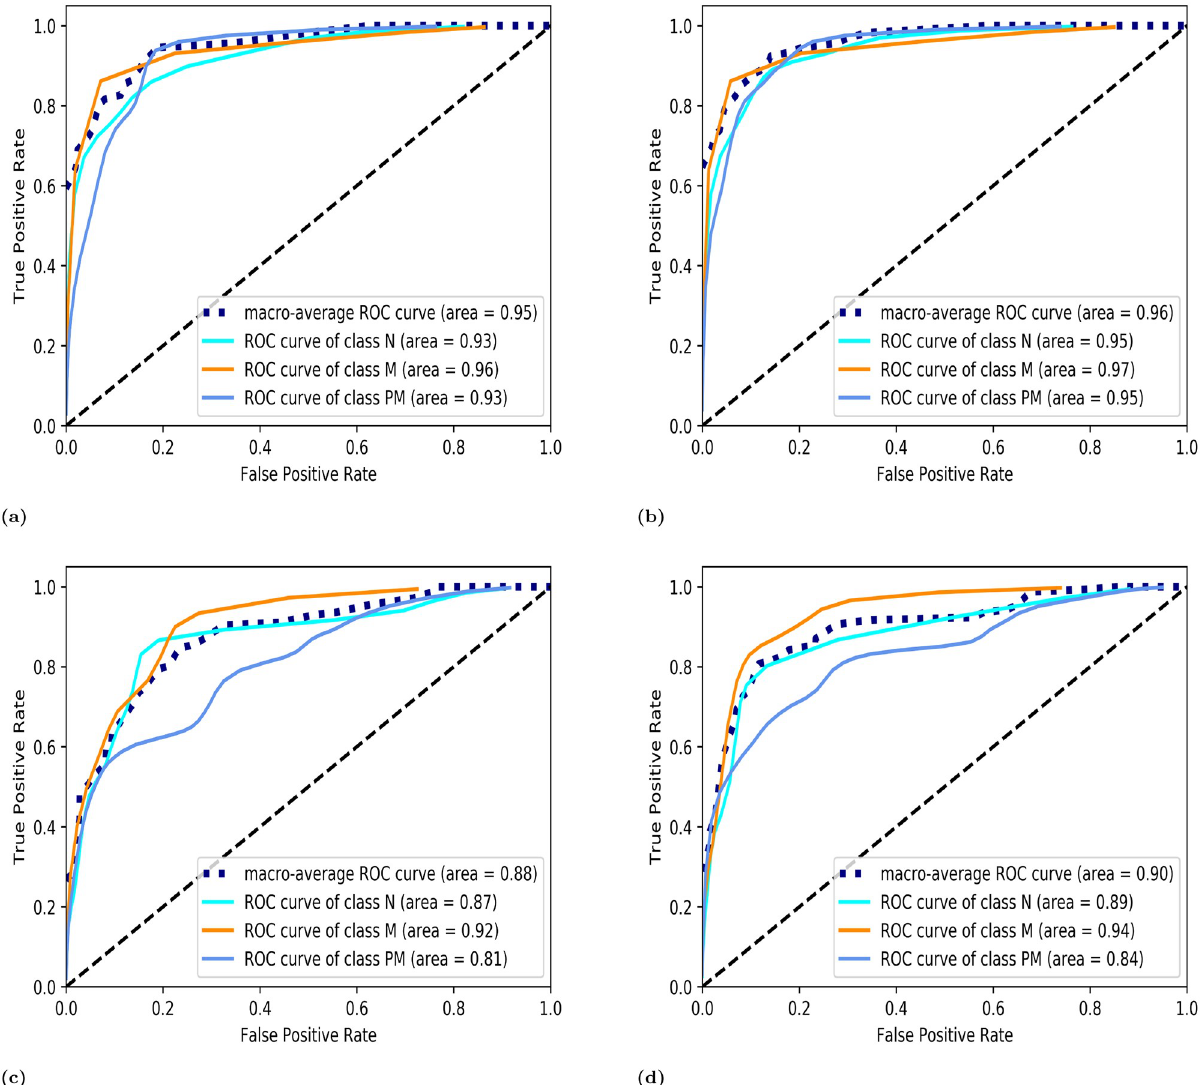
Fig 5. ROC curves were plotted (a) For normalized data of tongue using LDA and (b) QDA classifier (c) For normalized data of buccal mucosa using LDA and (d) QDA classifier. Where N is normal, PM is premalignant and M is malignant. Macro-average ROC curve gives the average of the three